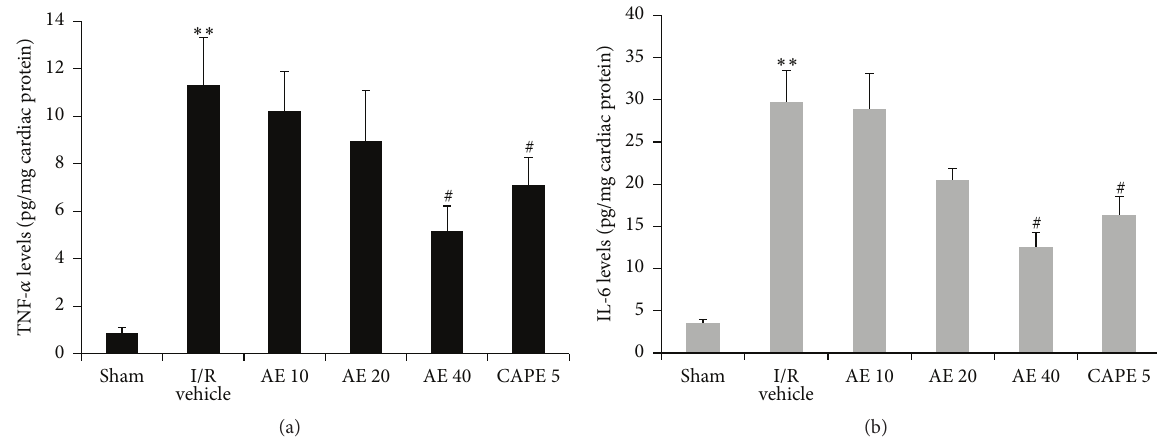
Figure 5: Effects of AE on TNF- 𝛼 and IL-6 after myocardial I/R in cardiac tissue. Hearts were subjected to 30 min ischemia followed by 24-hour reperfusion. (a) TNF- 𝛼 . (b) IL-6. Different doses of AE (10, 20, or 40 mg/kg), CAPE 5 mg/kg, or saline (1mL/kg) were administered via the tail vein 1 min before reperfusion. 𝑛 = 5 /group. ∗∗ 𝑃 < 0.01 , versus Sham; # 𝑃 < 0.05 versus I/R vehicle.